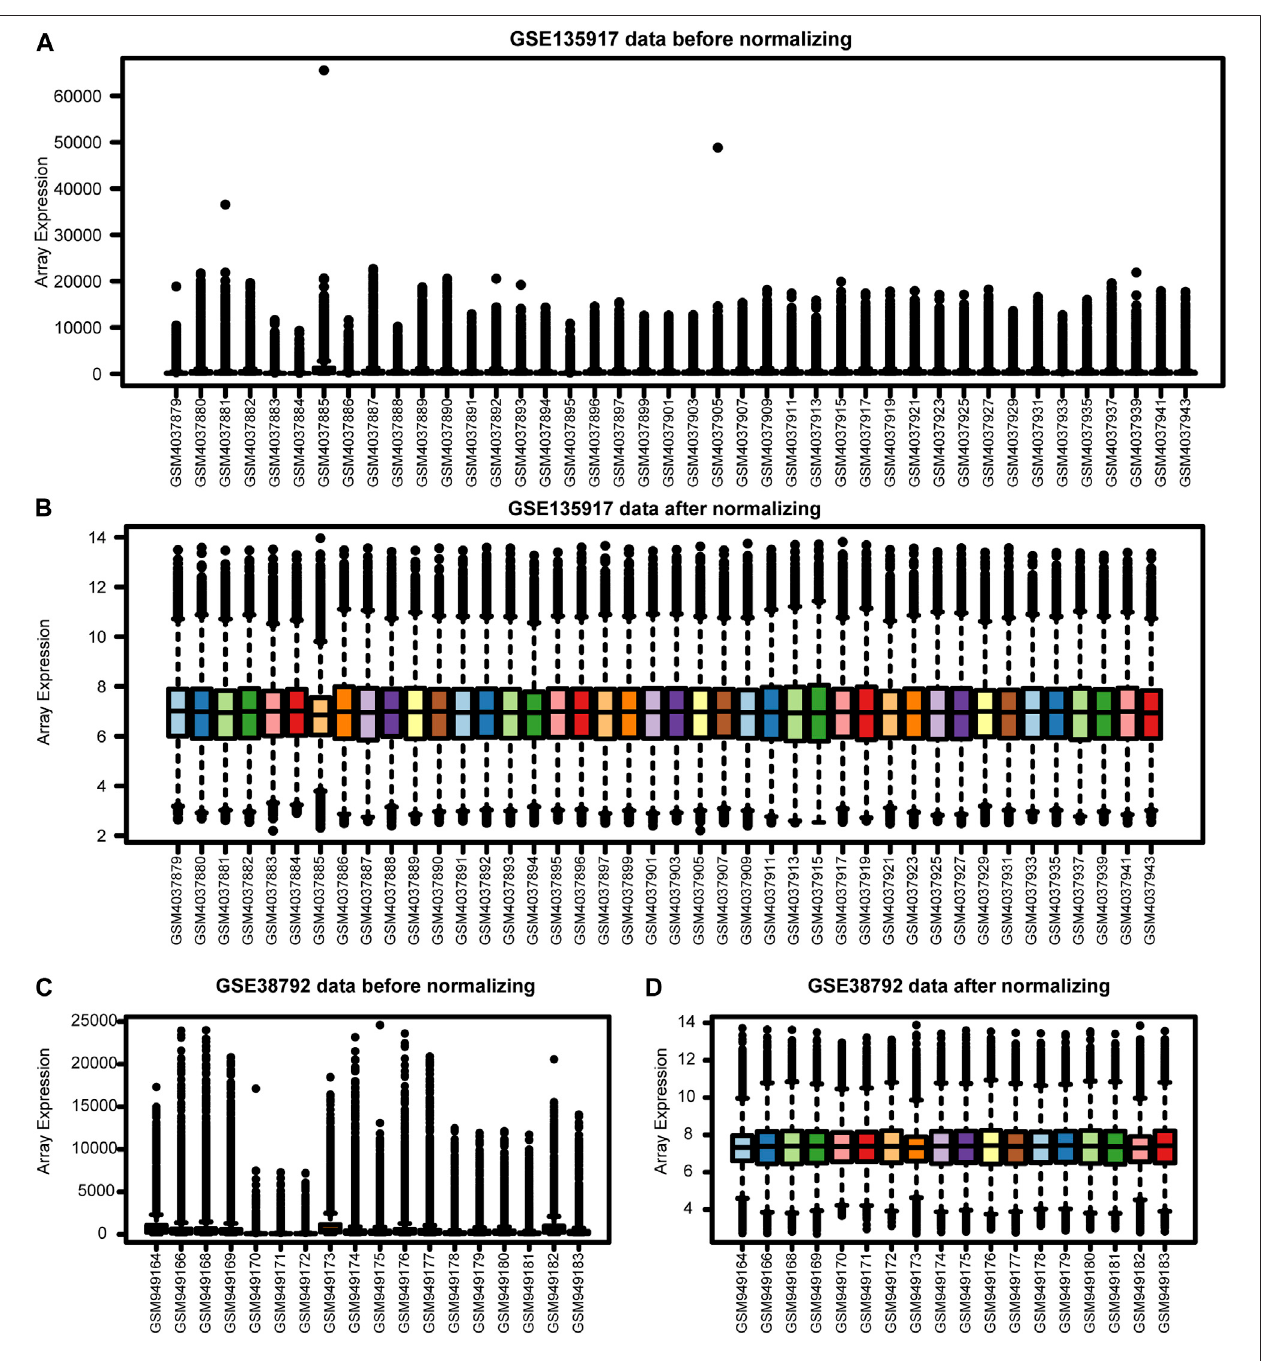
FIGURE 2 | The Expression pro fi les before and after normalization. (A) GSE135917 data before normalization. (B) GSE135917 data after normalization. (C) GSE38792 data before normalization. (D) GSE38792 data after normalization.